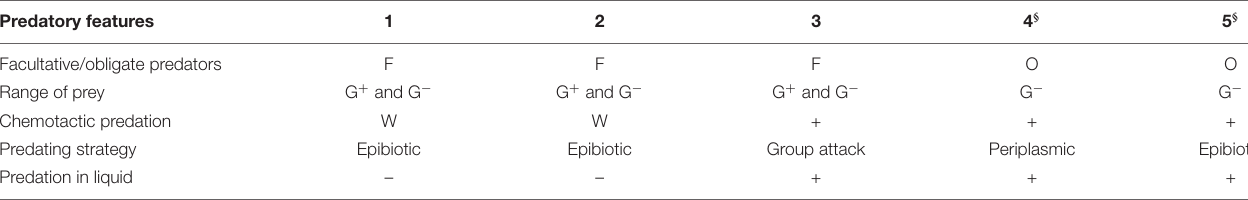
TABLE 3 | Predatory features between strain YN101 T and each type species of related genera. Predatory features